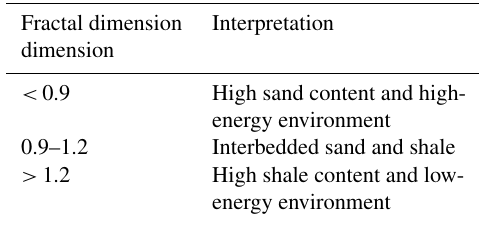
Table 2. Ranges of fractal-dimension